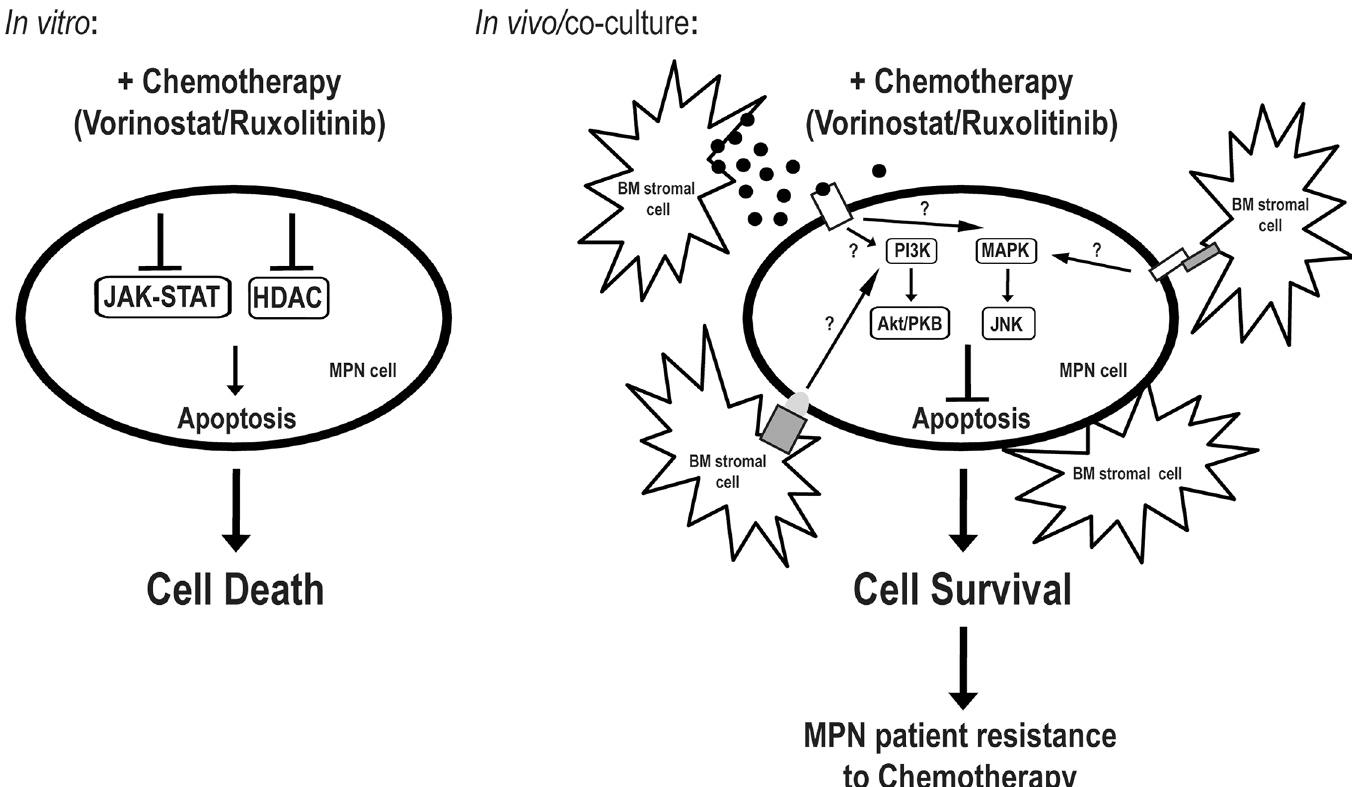
Fig 5. Model for the proposed BM mediated protection of MPN cells. In vitro , MPN cells (SET-2, HEL, UKE-1 cell lines and MPN patient BM-derived Lin - CD34 + cells) are killed once exposed to chemotherapeutic agents, like Vorinostat and Ruxolitinib, as a result of the inhibition of HDAC enzymes and JAK2V617F mutant protein kinase, respectively. However, in vivo (in MPN patients) or in the co-culture assays with the HS-5 BM stroma, MPN cells are able survive the cytotoxic action of these noxious agents through the activation of the JNK and PI3K signalling pathways, allowing MPN cells to escape these chemotherapeutic regiments and prolonging disease in MPN patients. The mechanisms underlying the activation of these signalling pathways are still elusive, but we postulate that involves the secretion of soluble factors by the BM stroma and the direct interaction between the MPN cells and the BM